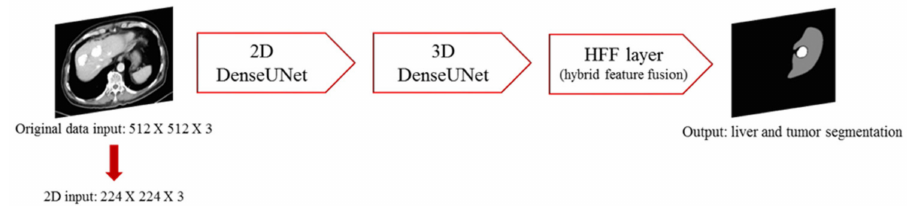
Figure 3. Identification process of H-DenseUnet.